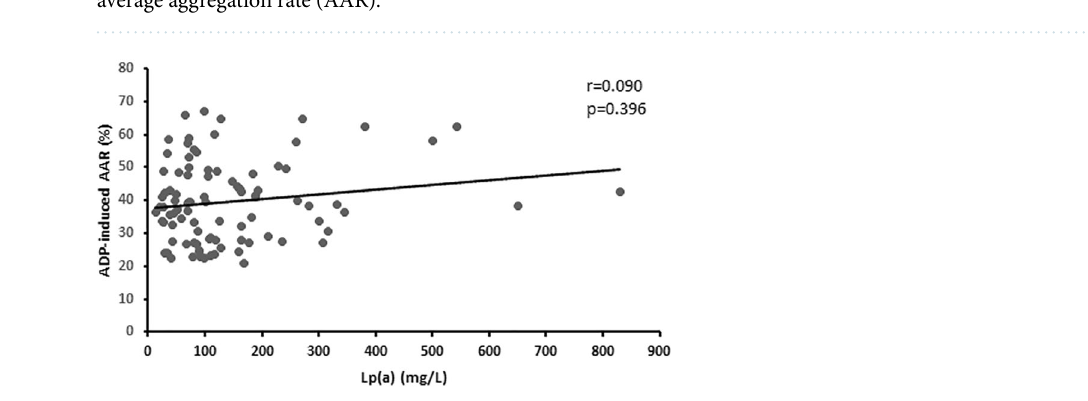
Figure 2. Correlation analysis of AA-induced platelet aggregation. Univariate linear correlation of TC ( A ), TG ( B ), HDL-C ( C ), LDL-C ( D ), ApoA1 ( E ), ApoB ( F ), NEFA ( G ), PLT ( H ), and Lp(a) ( I ) with AA-induced platelet average aggregation rate (AAR).